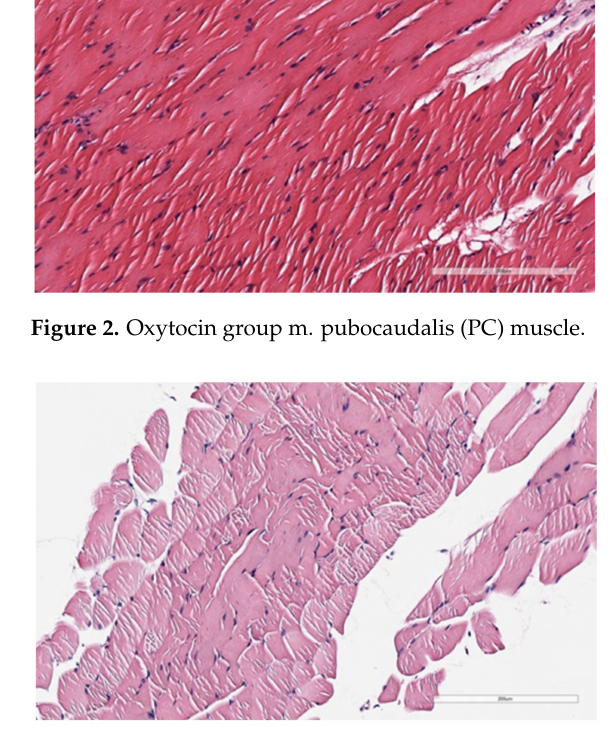
Figure 3. Saline solution group m. coccygeus (C)